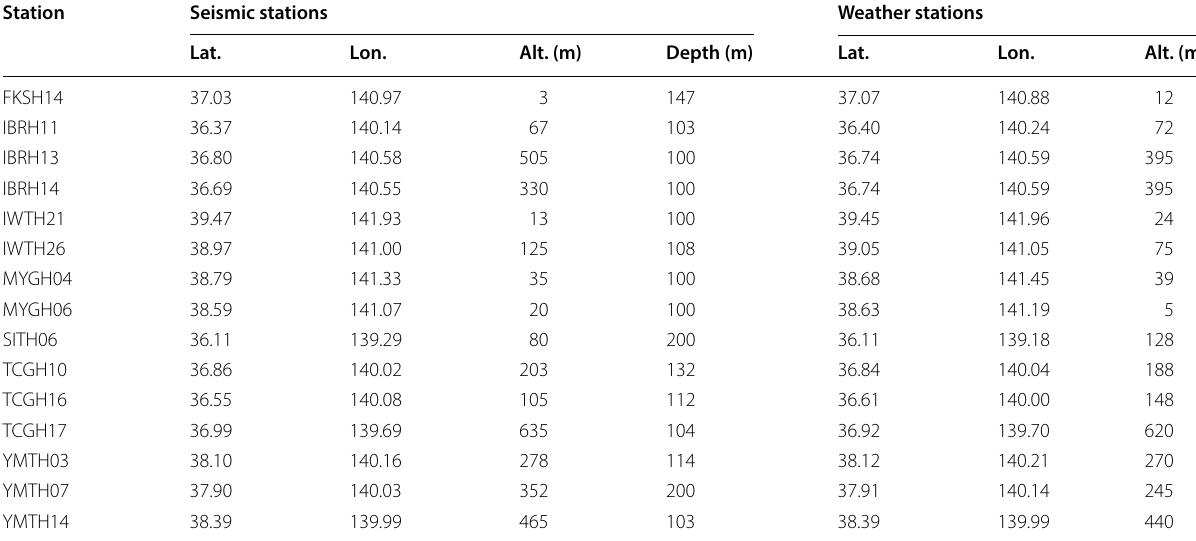
Table 2 Locations of the selected seismic stations and corresponding weather stations Station Seismic stations Weather